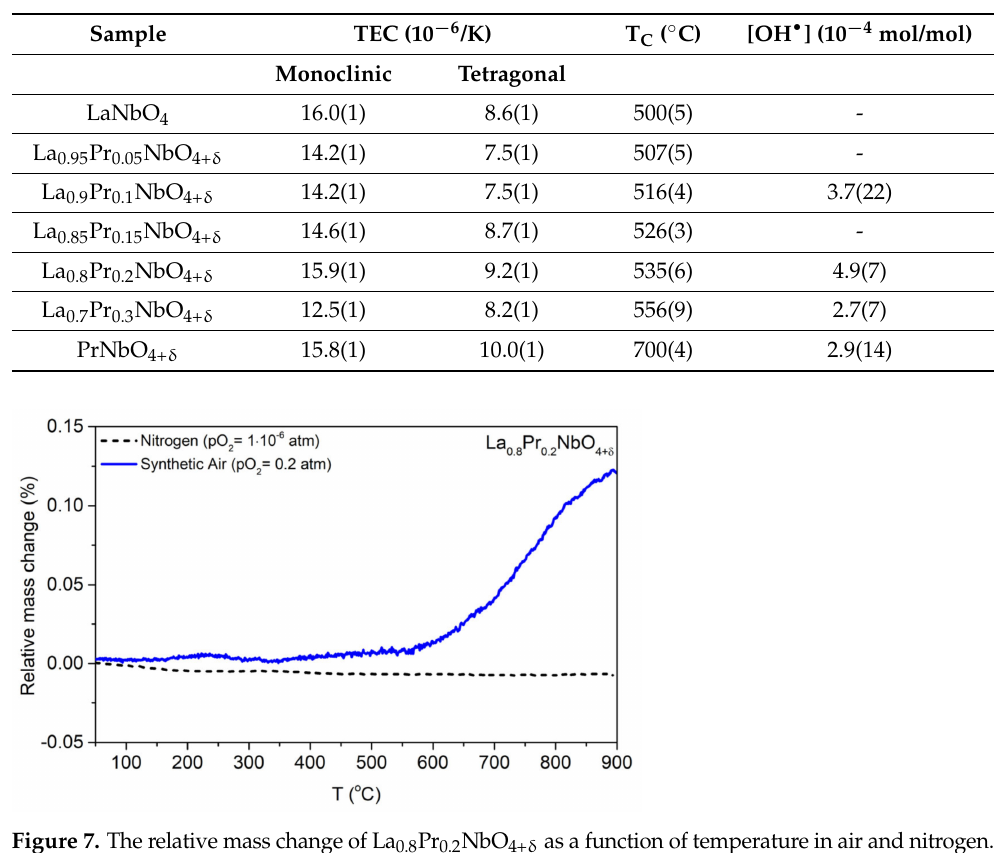
Table 3. Phase transition temperature (T C ) and thermal expansion coefficient (TEC) for monoclinic and tetragonal structure and calculated proton concertation at 300 ◦ C in wet air of La 1 − x Pr x NbO 4+ δ .